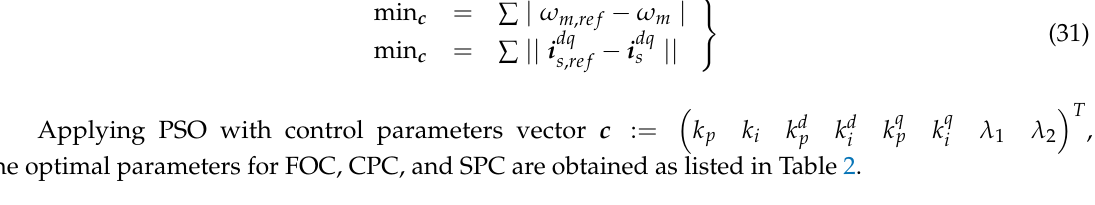
Table 2. Motor, execution, and controller